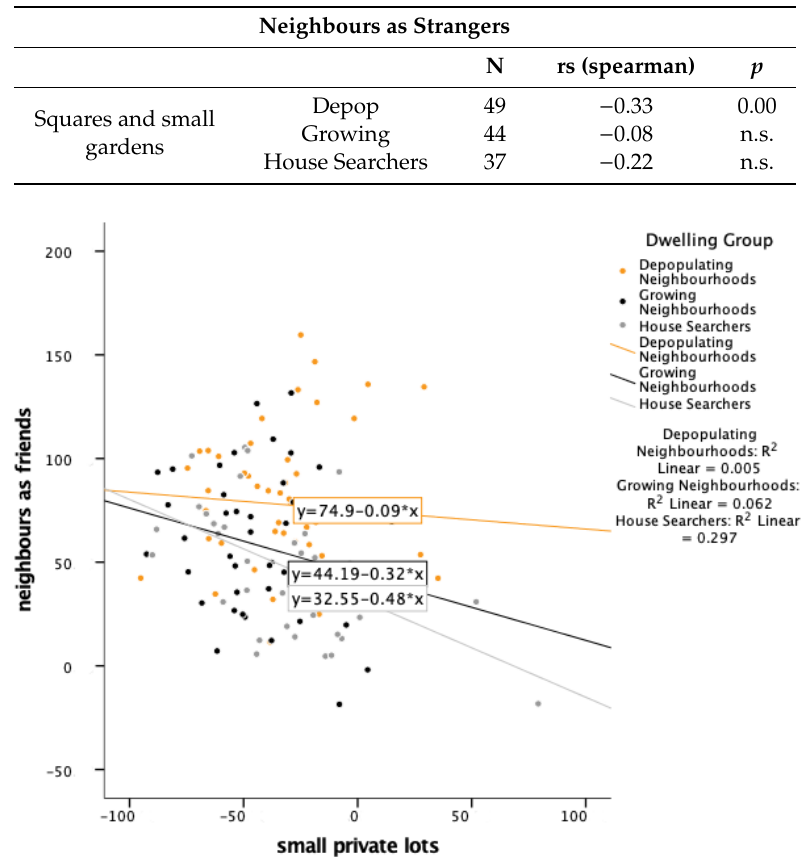
Figure 3. Correlations between the levels “private or semi-private lots” and “neighbours as friends”, according to the subgroups: “depopulating neighbourhoods”, “growing neighbourhoods”, and “house searchers” (Pearson test) showing the R2 levels.